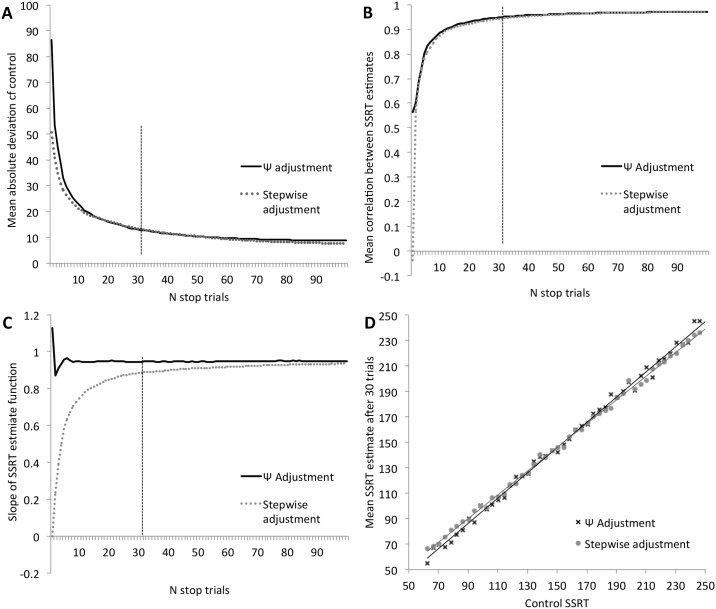
Results from horse-race model simulations with fixed Go RT distribution and varied stop RT.Stop RT was systematically varied around the starting point of the stepwise-adjusted staircase and across the parameter space considered by the Bayesian Ψ staircase. (A) Mean absolute deviation from the control SSRT as a function of staircase stop trial. (B) Mean correlation between SSRT estimates as a function of staircase stop trials. (C) Slope of the best fitting affine function describing the relationship between actual SSRT and estimated SSRT (a slope of less than 1 suggests overestimation of fast SSRT and underestimation of slow SSRT). (D) Mean SSRT estimate after 30 stop trials plotted against control SSRT.